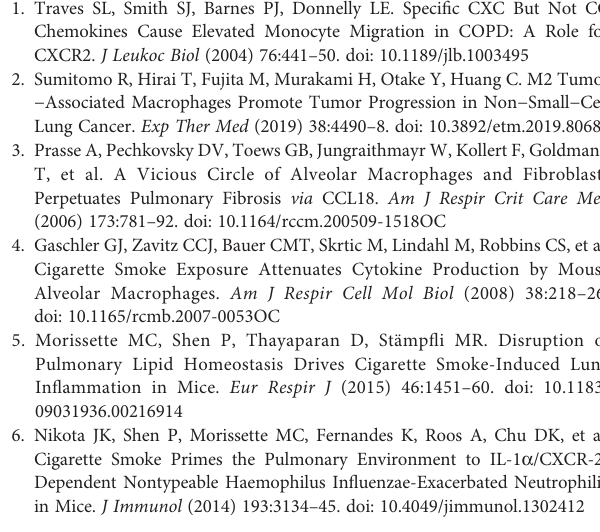
NanoStringat (B) day 7 and (C) day 21. (D) Representative images for H&E-stained sections. Data show mean ± SEM,n=4-10. Two-way ANOVA with Tukey ’ s multi- comparison test. RA, room air; CS, cigarette smoke. Supplementary Figure 6 | CD38 + macrophagesareincreasedincigarettesmoke- exposedbleomycin-treatedmice.C57BL/6femalemicewereadministeredbleomycin (0.05U/mouse) or control saline following 12-weeks of RA orCS exposure. Graphs demonstratetotalnumbersofIM1,IM2,andIM3populationsexpressingCD38,CD206 and CD38/CD206 inlungtissue following (A) 7 daysor (B) 21 daysof bleomycin administration. Total lung cellcounts (C) day 7 and (D) day 21. Adherent lungCD45 + lactosedehydrogenase release in ex vivo TGF- b 1, IL-6 andIL-4 stimulated cell supernatantfrom (E) 12-week roomair (RA)- orcigarette